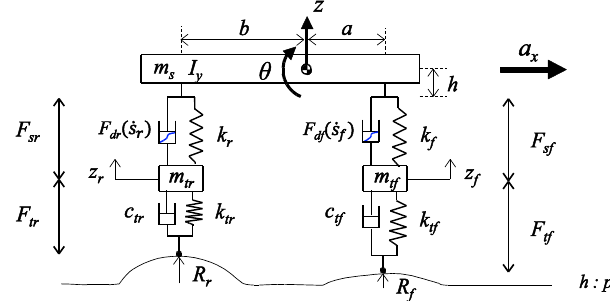
Figure 2. Half car model for vertical dynamics.